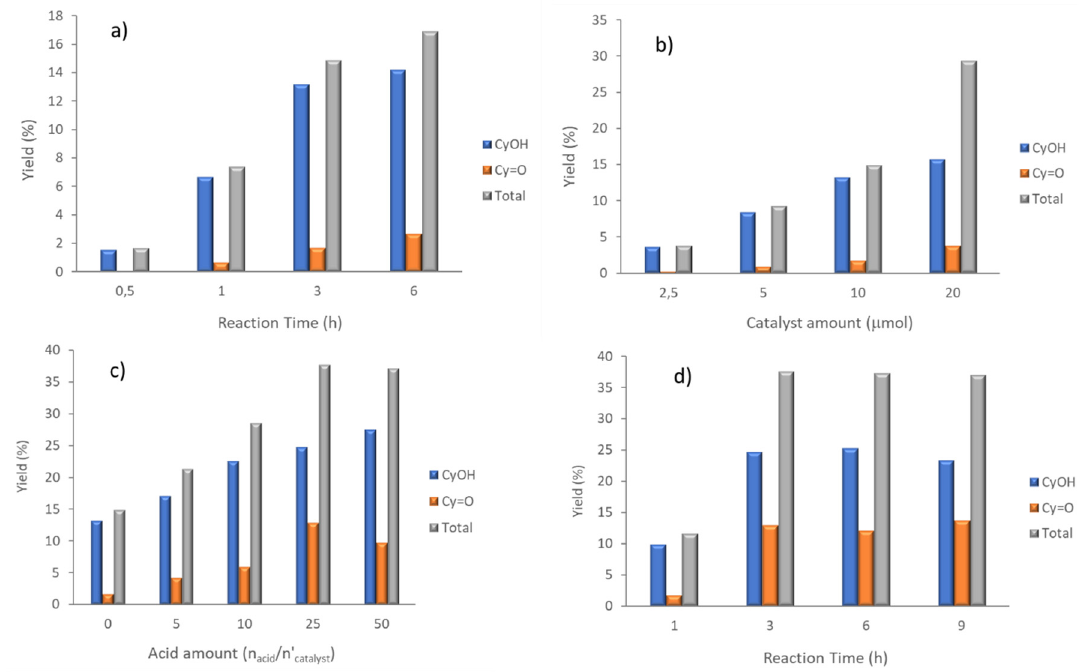
Figure 2. Oxygenated product yield of cyclohexane (CyH) oxidation [cyclohexanol (CyOH) + cyclohexanone (Cy=O)] with respect to the following: ( a ) reaction time (10 μ mol of 1 ); ( b ) catalyst amount (3 h reaction time); ( c ) acid amount (10 μ mol of 1 and 3 h reaction time); and ( d ) reaction time in the presence of acid additive [10 μ mol of 1 and n(HNO 3 )/n ʹ (catalyst) = 25]. Other reaction conditions: CyH (5 mmol); NCMe (3 mL); TBHP (70% aqueous) (10 mmol); 50 °C; under MW-irradiation (5 W); and GC analysis after the addition of PPh 3 .